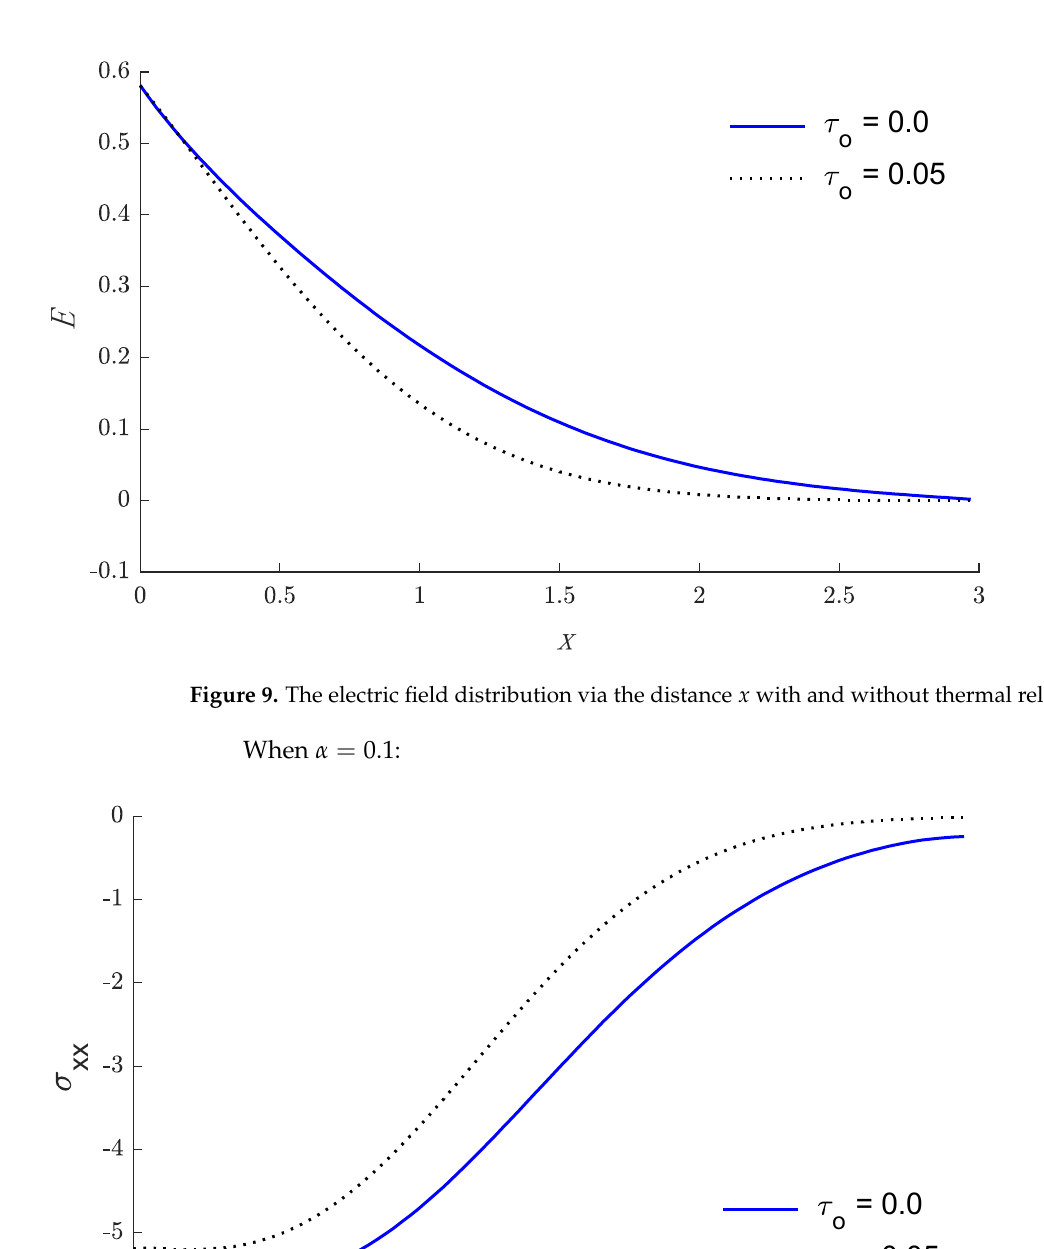
Figure 8. The displacement distribution via the distance 𝑥 with and without thermal relaxation time. When 𝛼 = 0.1 :